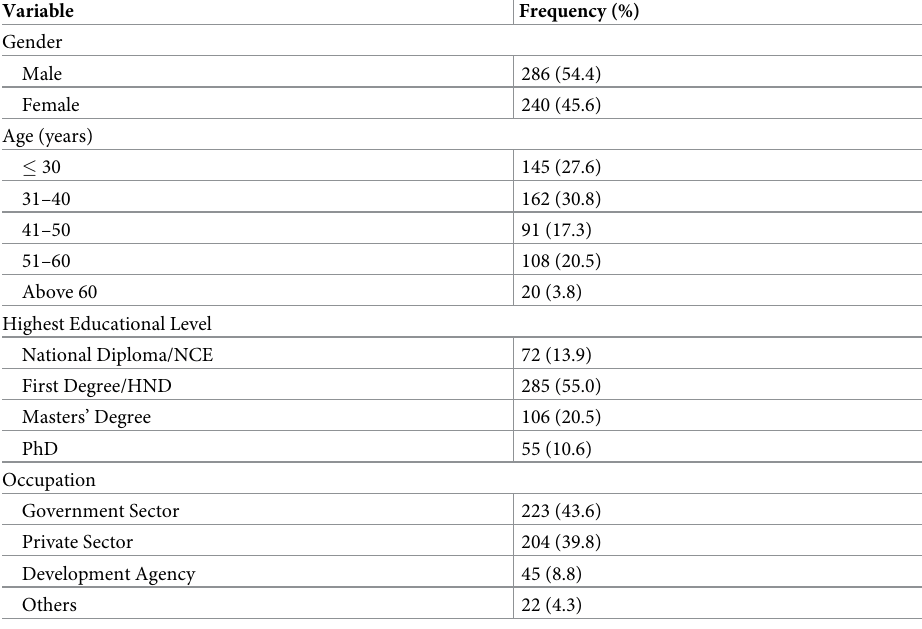
Table 1. Socio demographic characteristics of participants.